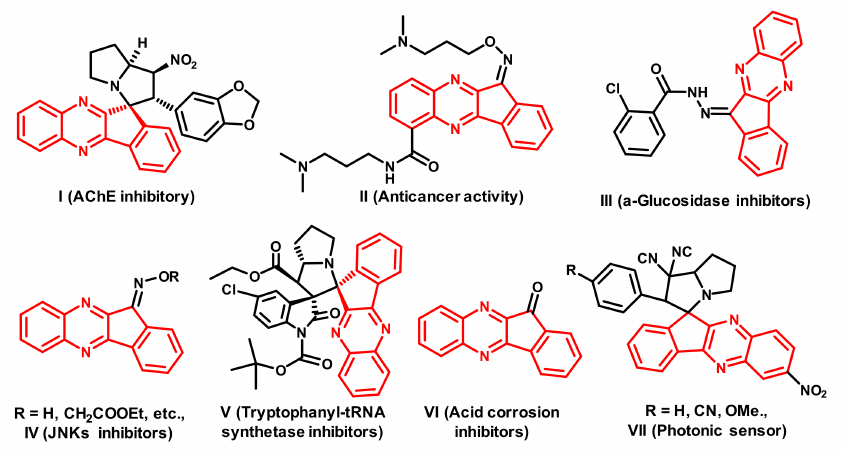
Figure 1. Some active compounds of the indeno[1,2-b]quinoxaline